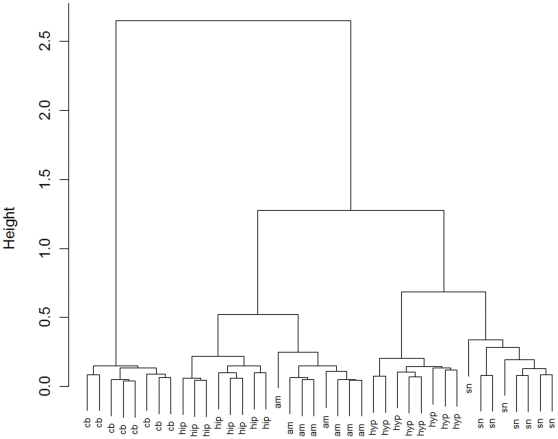
Cluster dendrogram of miRNA expression profiles demonstrates samples grouped according to their biological origin in the brain of adult male rats.The dendrogram shows that the samples from five brain regions are grouped according to their biological relatedness, suggesting that the miRNA expression profiles overall contain region-specific information. The branch lengths of the dendrogram are measures of the difference between samples and show that the within-region variability in miRNA abundances is low compared to the between-region variability. Average standard deviations of the regional miRNA expression levels are 0.43 (am), 0.37 (cb), 0.39 (hip), 0.43 (hyp) and 0.47 (sn). am: amygdala; cb: cerebellum; hip: hippocampus; hyp: hypothalamus; sn: substantia nigra.